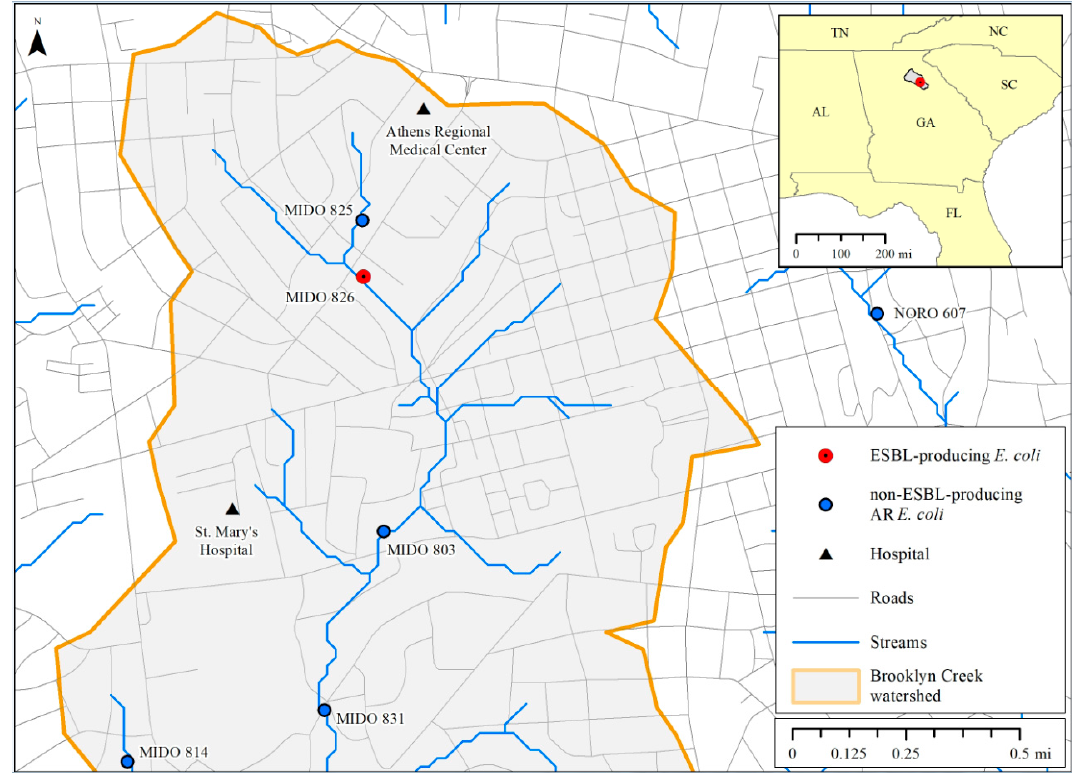
Figure 3. Map of water sampling sites in the Brooklyn Creek watershed in Athens, GA. Sampling site where extended-spectrum β -lactamase (ESBL)-producing E. coli was isolated (MIDO 826) is colored red. Sampling sites where Non-ESBL-producing E. coli were isolated are in blue. Hospitals are symbolized as black triangles.